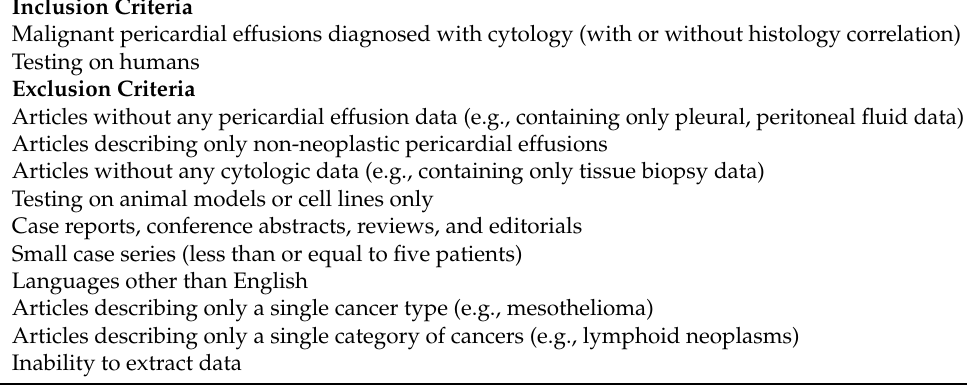
Table 1. Inclusion and exclusion criteria of this systematic review. Inclusion Criteria Testing on humans Exclusion